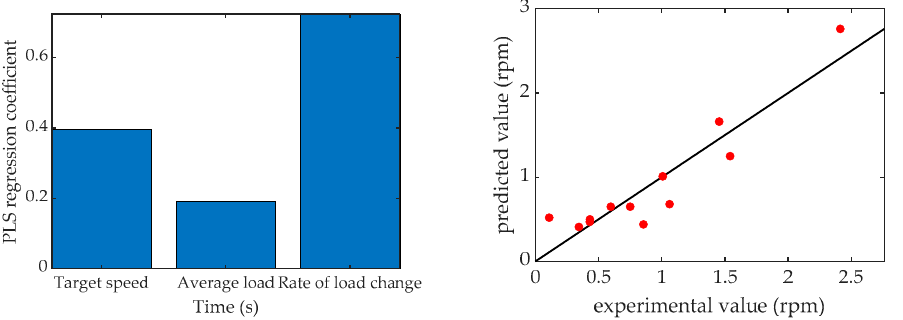
Figure 16. Influence of the parameter on the standard deviation of speed.